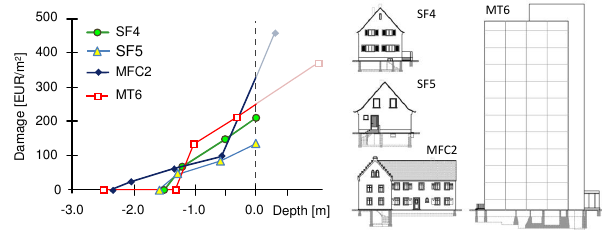
Fig. 9. Selected examples of depth-damage functions due to ground- water inundation in the city of Dresden (damage type: moisture and water